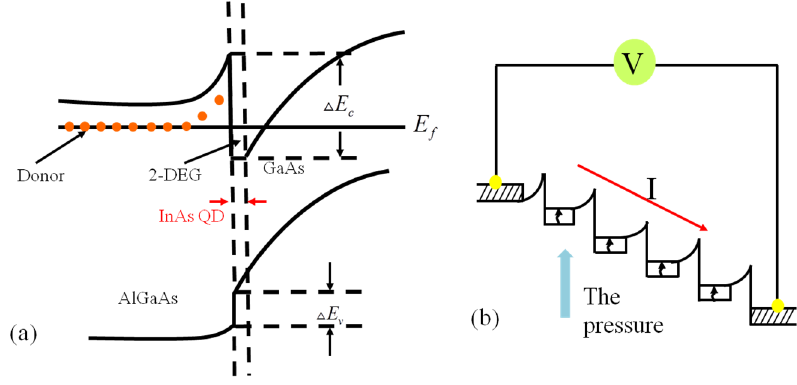
Figure 3. ( a ) The energy level diagram of QD-HEMT ( b ) the change of current flow under